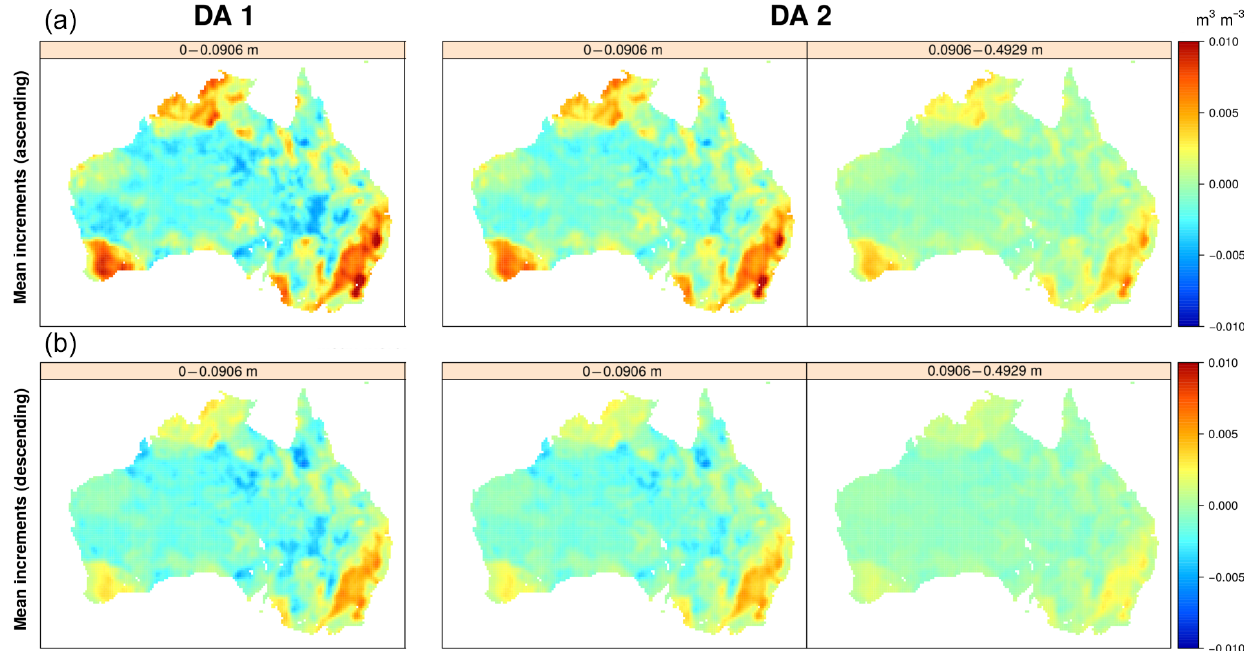
Figure 6. Mean of all increments for experiments DA 1 and DA 2 for top-layer soil moisture and root-zone soil moisture for ascending (a) and descending orbits (b) . Biases are strongest for the ascending orbit, and distinctive spatial patterns are visible. Biases are strongly reduced both for deeper layers and descending orbits.